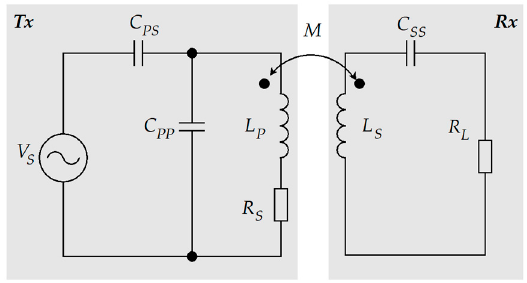
Figure 1. LCC-S-compensated topology for wireless power transfer systems.